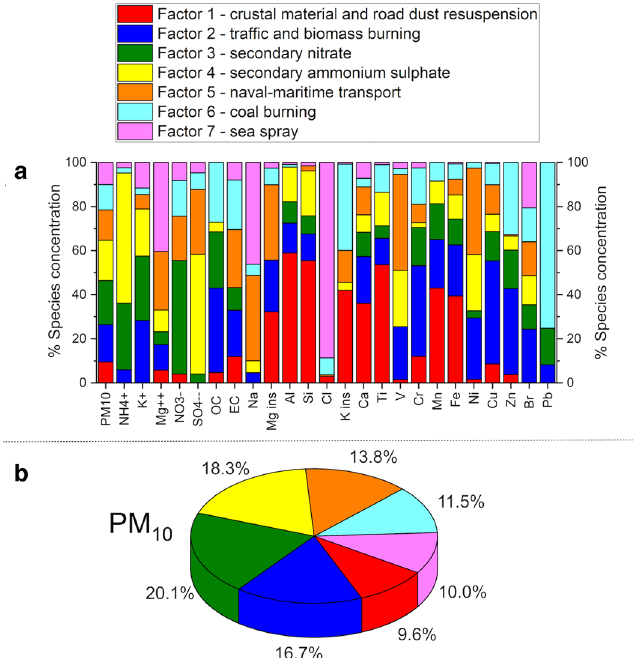
Figure 1. Emission sources identified by PMF analysis. ( a ) Stacked bar chart of the percentage concentration of each chemical species contributing to each of the seven factors that represent the chemical profile of each source identified in the PMF model. ( b ) Pie chart representing the contribution of the seven sources to PM 10 mass. The seven factors were identified as reported at the